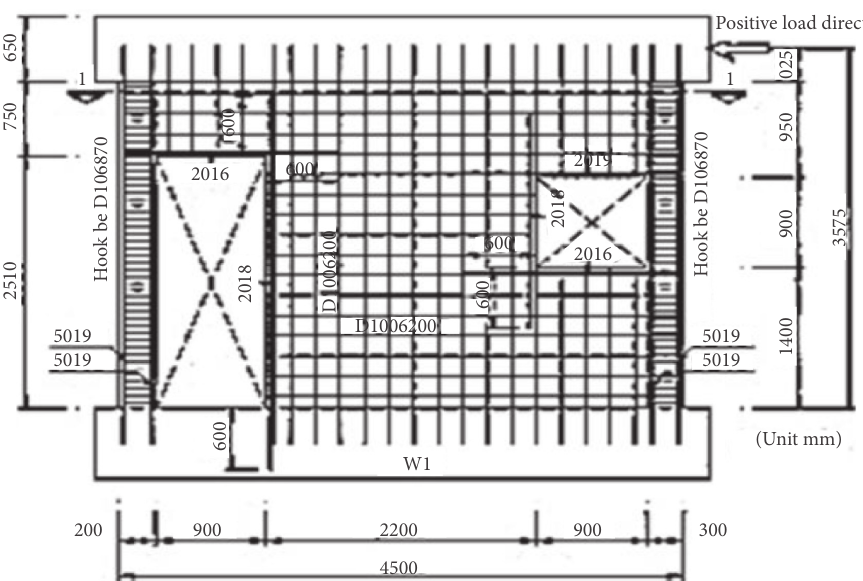
Figure 3: Scheme of a reinforced concrete panel [22].